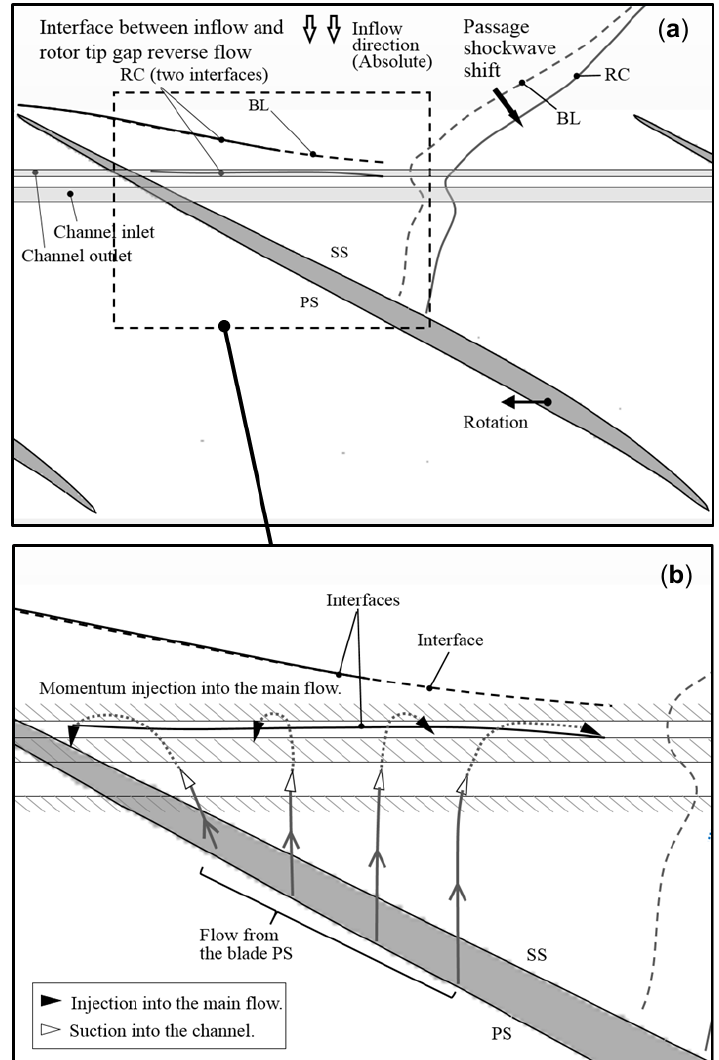
Figure 17. Diagram summarizing the working principle of the casing channel.